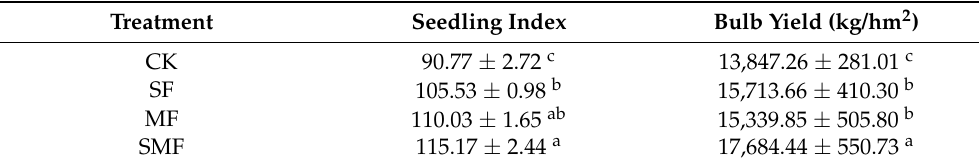
Table 1. Growth status of the Lanzhou lily over three years of constant application of silicon fertilizer and microbial agents: the significance is 0.05 for lower letters (a, b, c) presented in table.